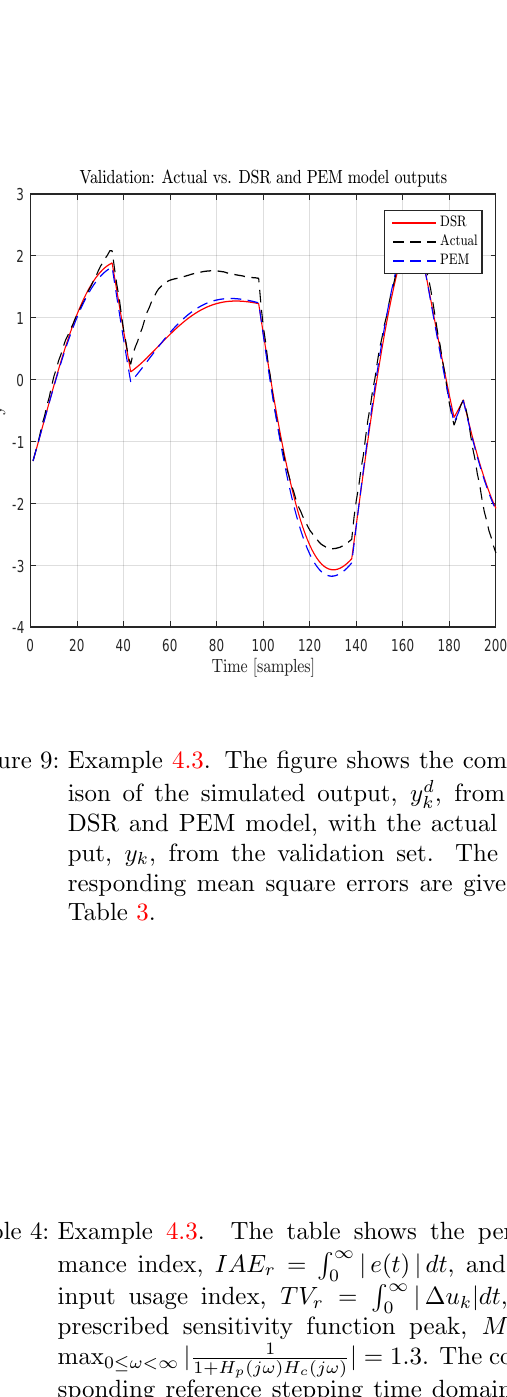
Figure 8: Example 4.3. The figure shows the compar- ison of the simulated output, y d DSR and PEM model, with the actual out- put, y k , from the identification set. The cor- responding mean square errors are given in Table 3.